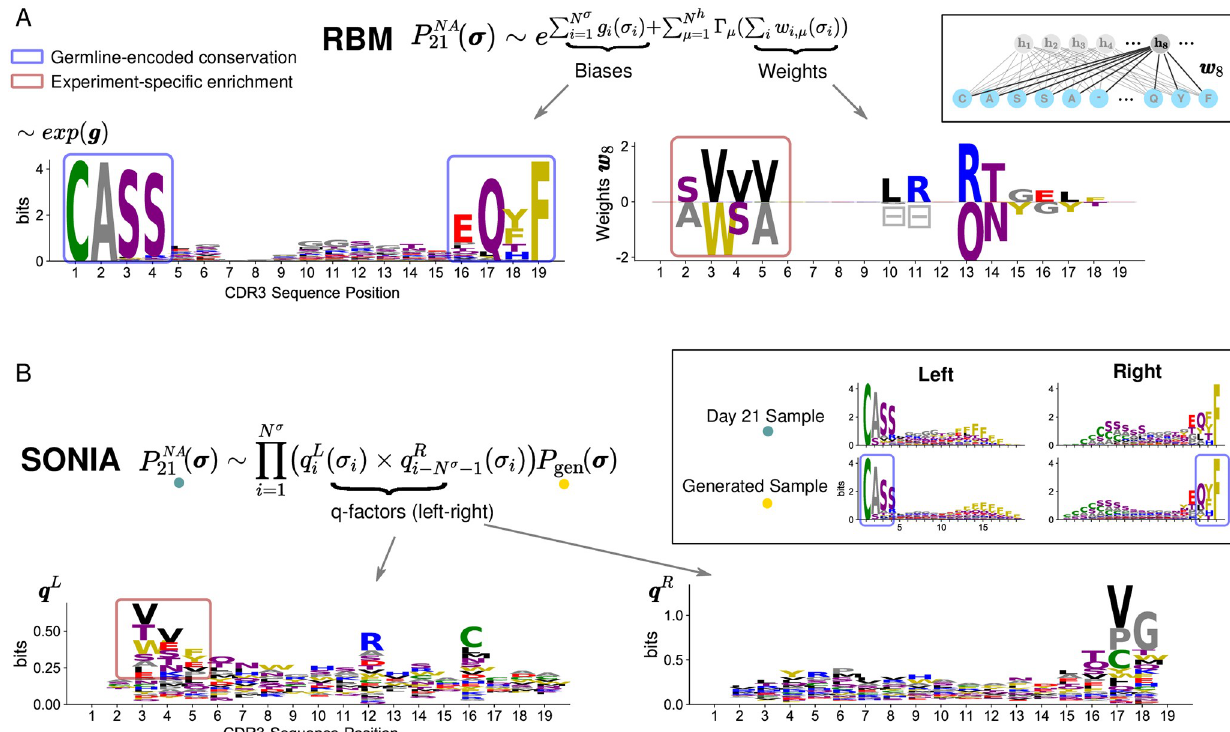
Fig 2. Inferred model parameters enable feature extraction. A: Using count-weighted datasets, the RBM infers the probability P NA ð σ Þ of detecting a 21 ð σ Þ is parametrized in terms of local biases g acting on CDR3 sites (left CDR3 sequence σ with high abundance at day 21 post stimulation by NA. P NA 21 column) and weights connecting each CDR3 site to a hidden unit, effectively coupling the CDR3 sites (right column). Inset: example of weights entering hidden unit 8, w 8 . The logo representation of exp( g ) normalized (left column) shows that single-site biases, by capturing the frequency of amino acids at each CDR3 site, reflect mainly the preferential usage of certain residues during the receptor generation process ( e.g . Cysteine at the beginning of the CDR3, Phenylalanine at the end position, blue boxes). For a given hidden unit, there is a set of weights for each site, with different values for each amino acid appearing at that site. These values can be either positive or negative and the height of the letter reflects the weight’s magnitude for the respective amino acid.